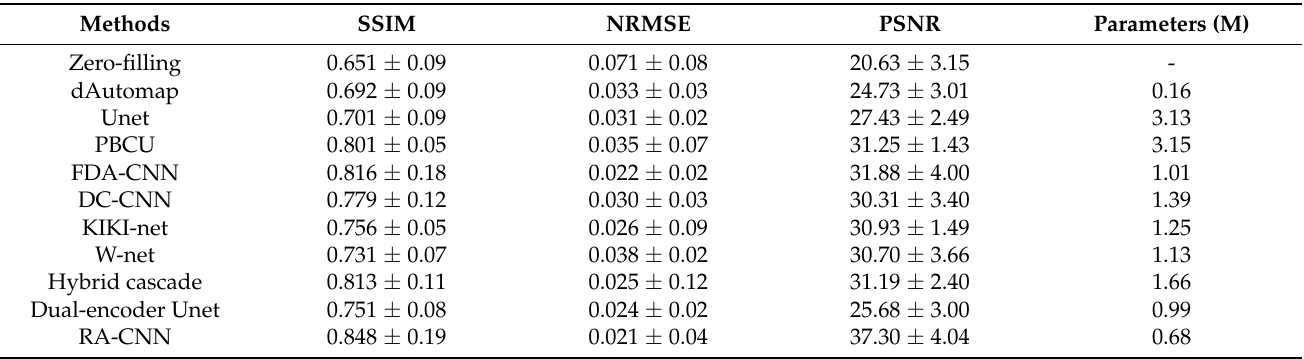
Table 2. Mean ± standard deviation SSIM, NRMSE, and PSNR values of the state-of-the-art methods obtained using AF